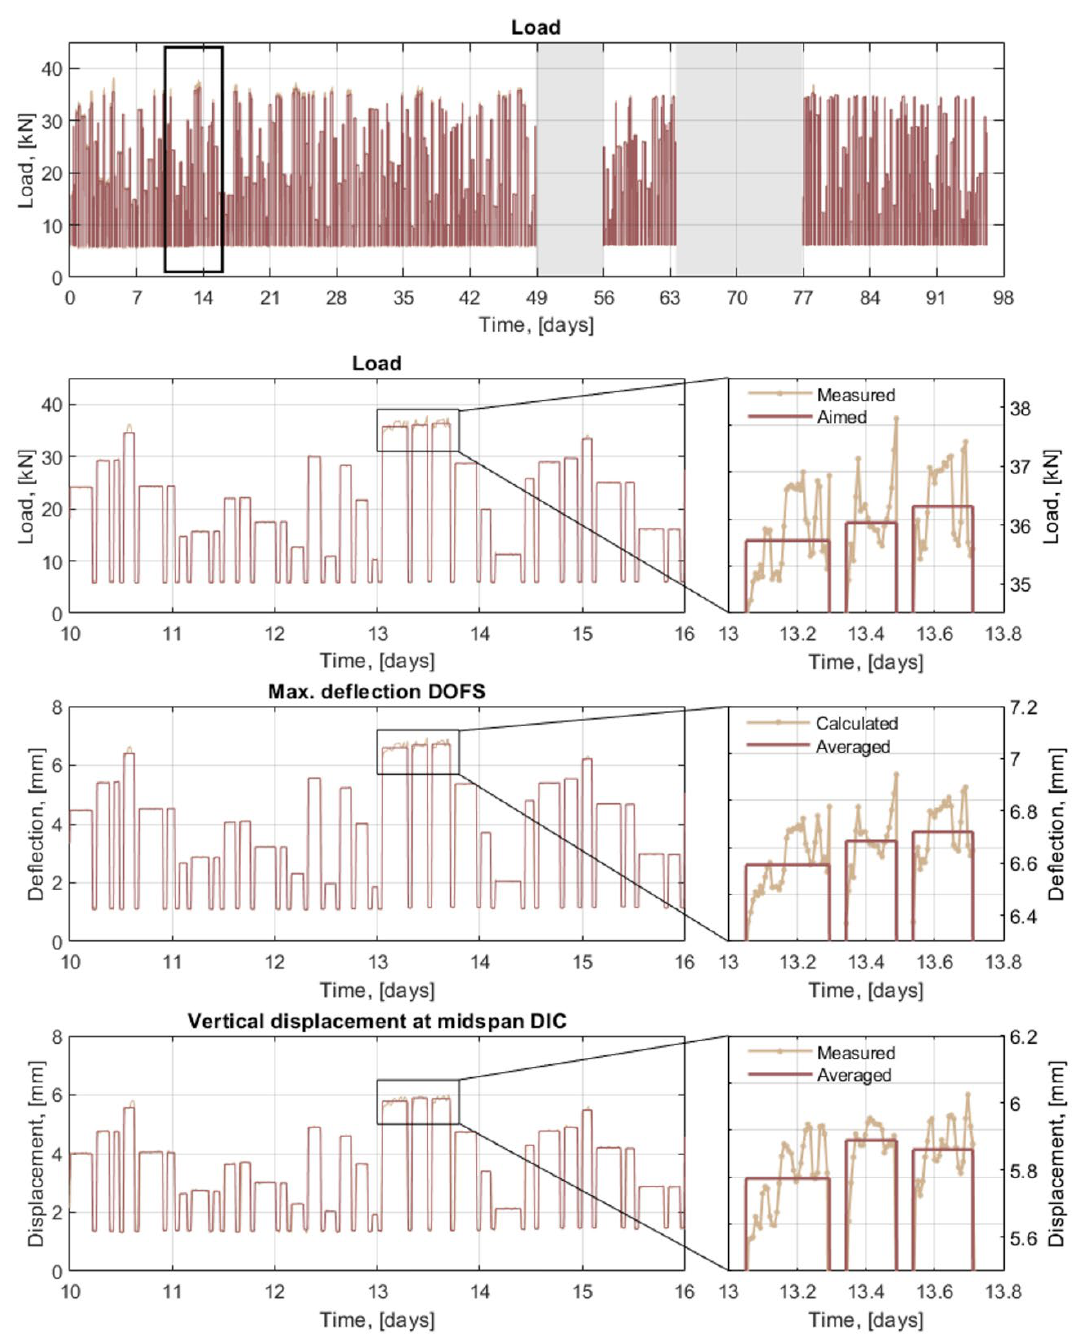
Figure 7. Load history of the beams subjected to cyclic loading. A zoomed-in region is presented to show the variability of the load cycles both in load magnitude and pulse duration and how the corresponding measurements of the DOFS and DIC correlate with the applied load. A further zoomed-in region is presented for the load, DOFS deflection and DIC displacement to illustrate the noise of the load-control system and the averaged values used for the analysis of